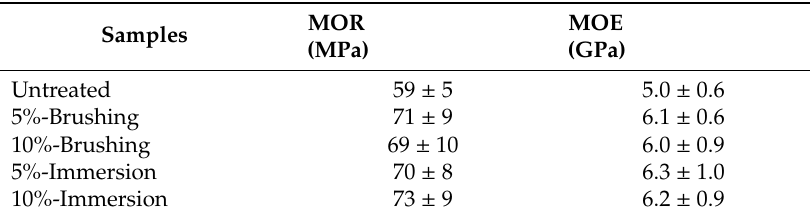
Table 3. Mechanical parameters estimated from the three-point bending test, modulus of resistance (MOR) and modulus of elasticity